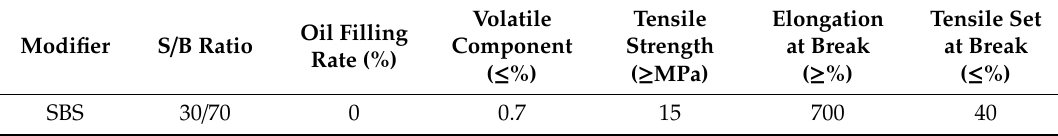
Table 2. Physical properties of SBS